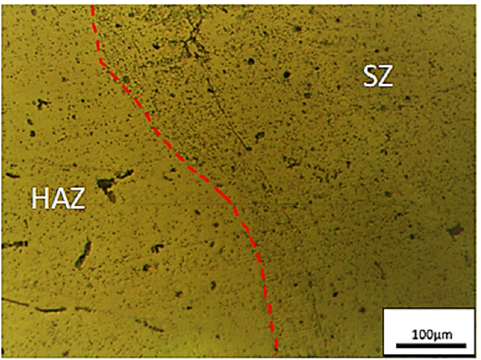
Figure 18. Micrograph (50×) showing distinctive features of the HAZ and SZ.